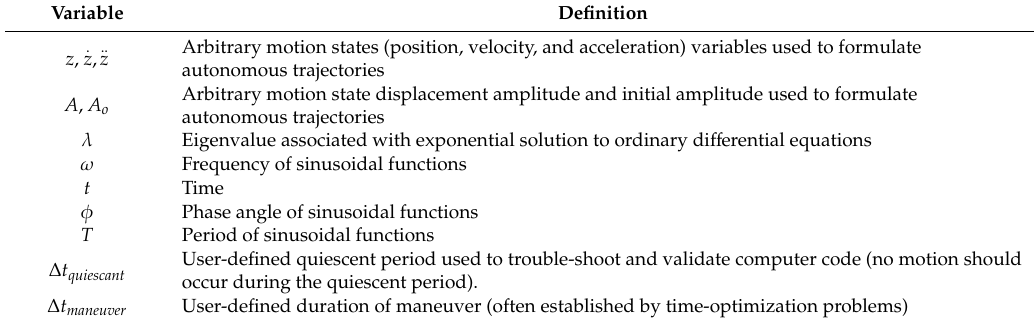
Table 2. Definitions of variables in this part of the manuscript (while a consolidated list is provided in the Appendix